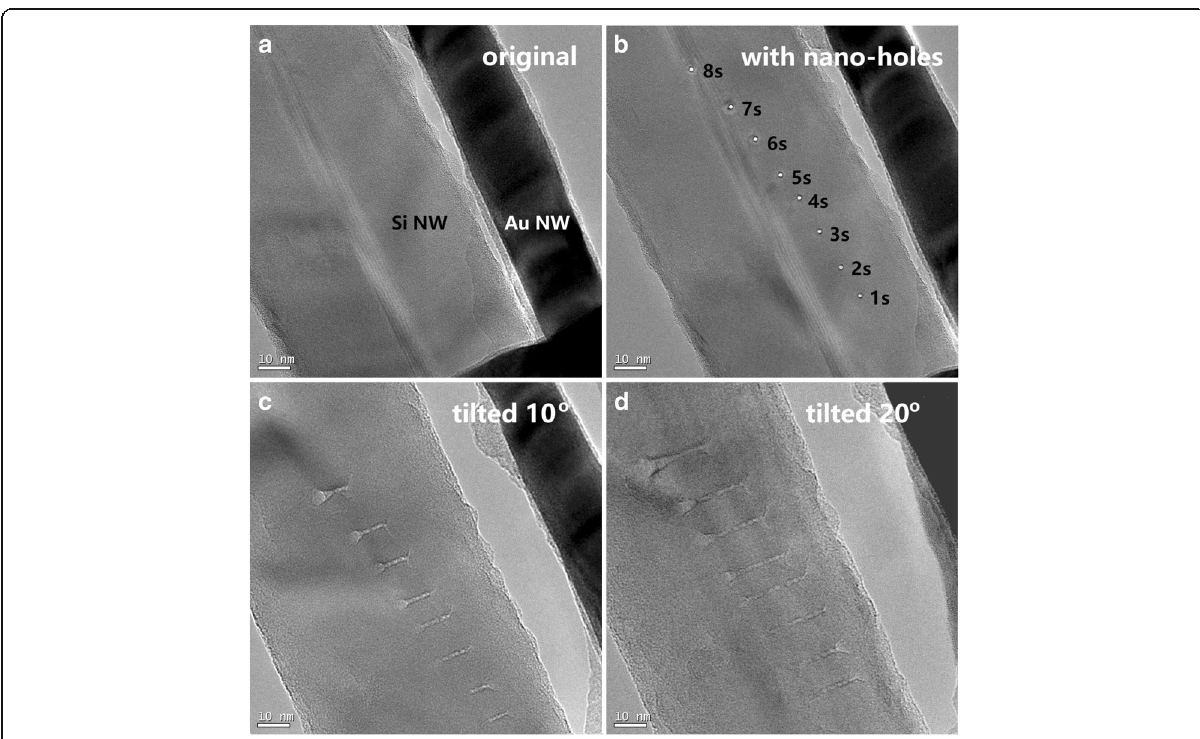
Fig. 1 TEM morphology images showing eight 1-nm holes drilled in a 60-nm-diameter single crystalline Si NW. This is done in 1 – 8 s, respectively, with a